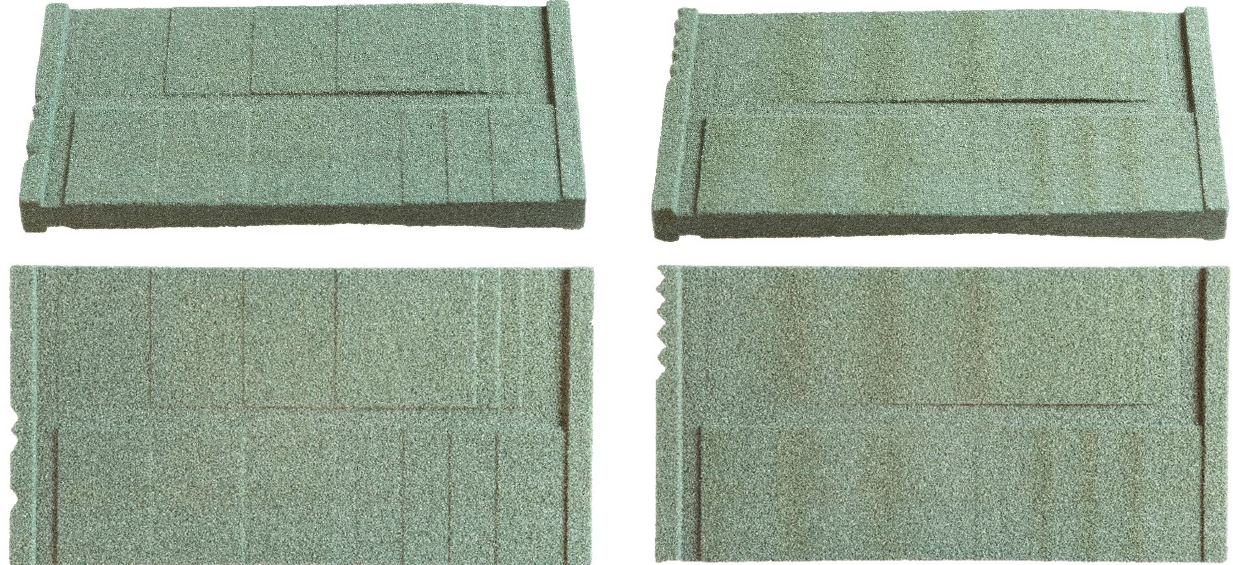
Figure 11. Two upskin perspectives on a conventionally printed part ( left ) and a smoothened part ( right ).